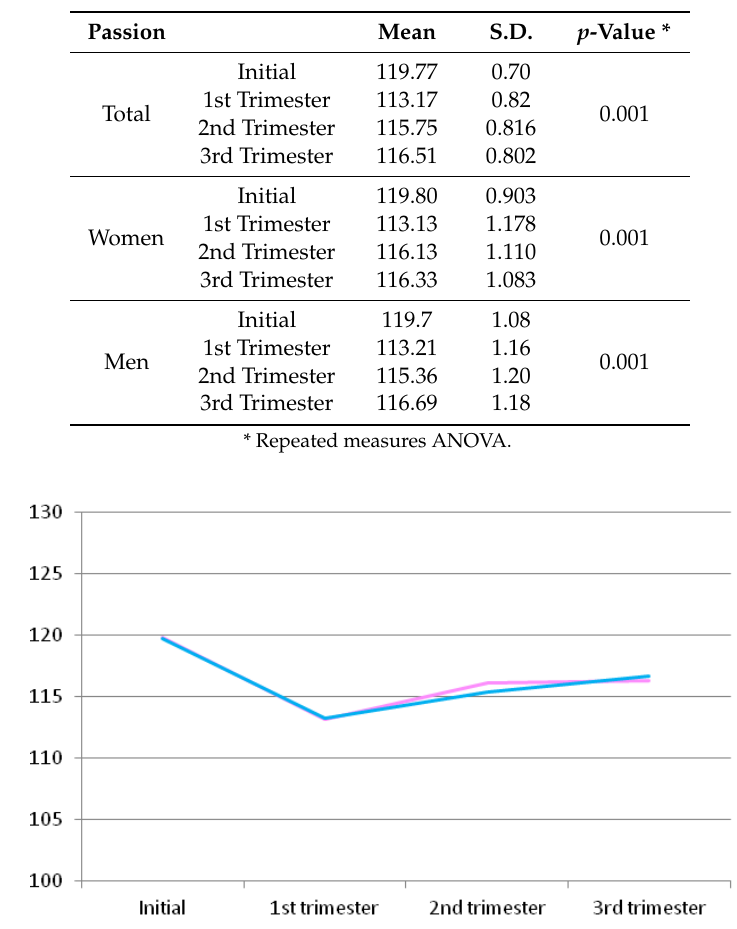
Figure 2. Intimacy scores for the men and women at different time points throughout pregnancy. Table 10. Initial and final passion means for each trimester.